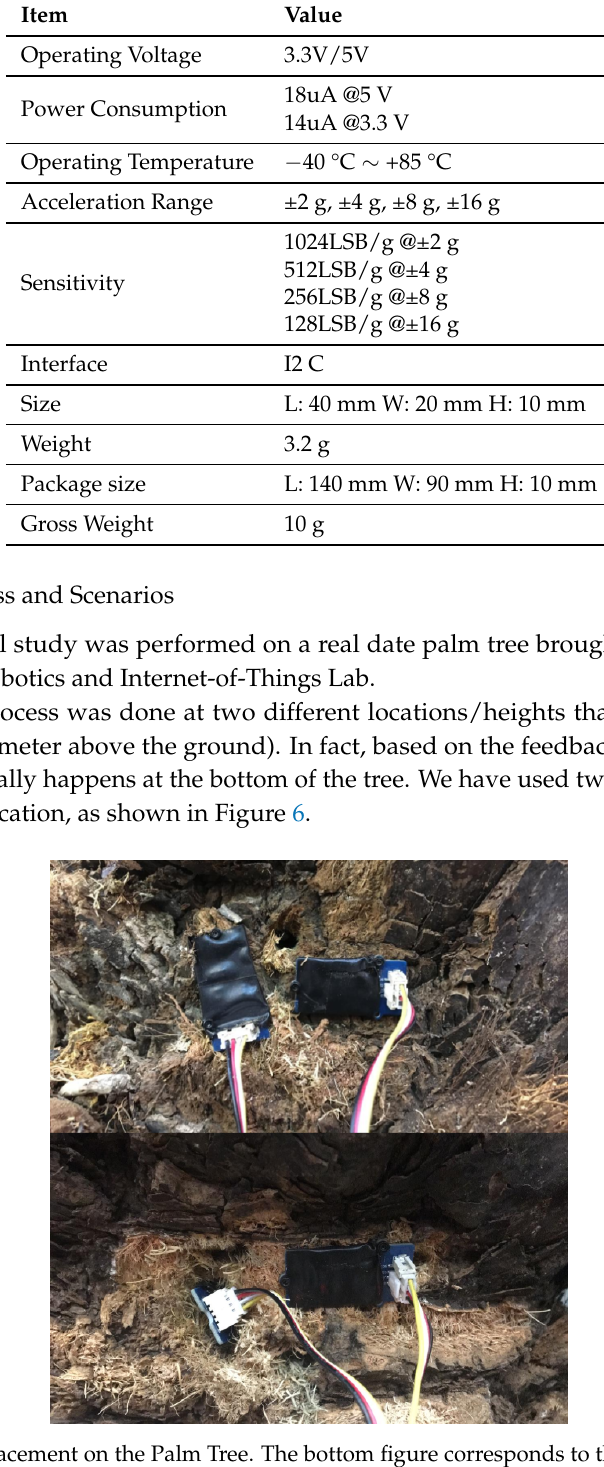
Figure 6. Sensor Placement on the Palm Tree. The bottom figure corresponds to the first scenario with one sensor inside and one sensor outside. The top figure corresponds to the second scenario with two sensors